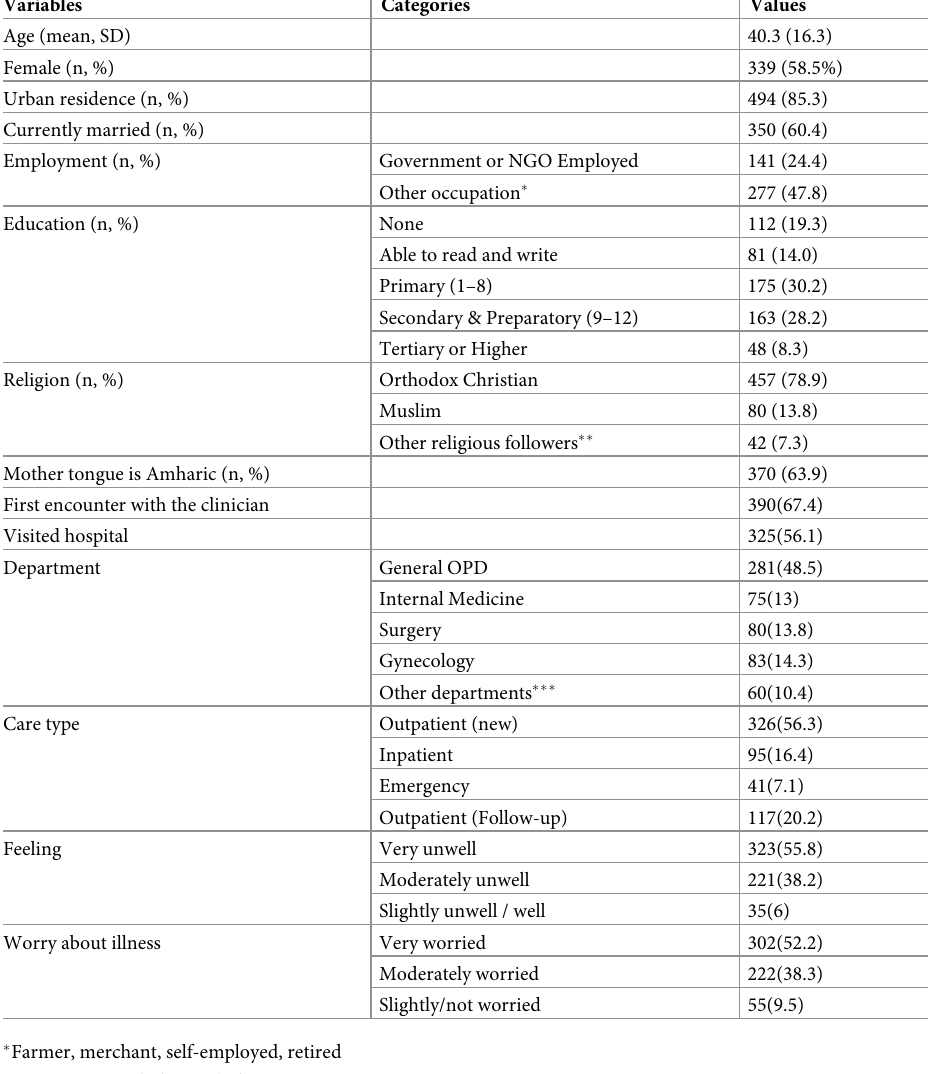
Table 1. Socio-demographic and clinical characteristics of study participants (n =